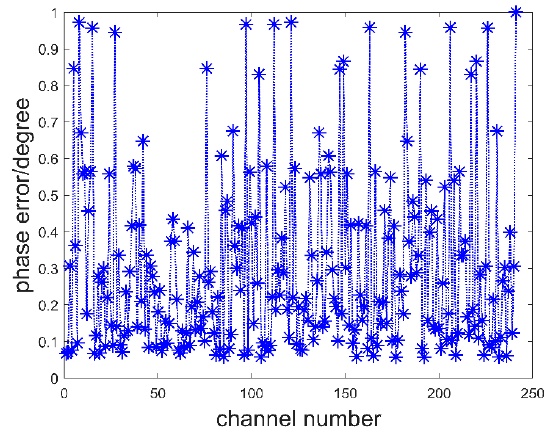
Figure 8. The channel phase error.